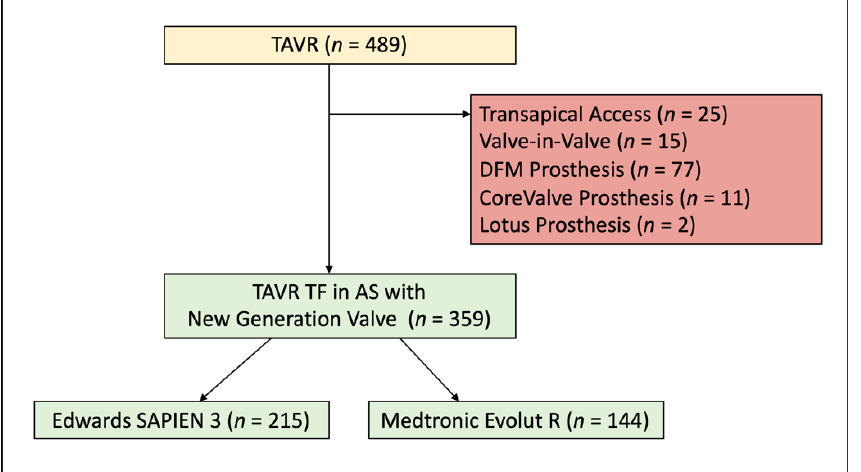
Figure 1. Patient Population. A total of 489 patients undergoing TAVR were screened for the analysis. Reasons for exclusion are displayed in the red box. TAVR = transcatheter aortic valve replacement; TF = transfemoral; AS = aortic stenosis; DFM = Direct Flow Medical.